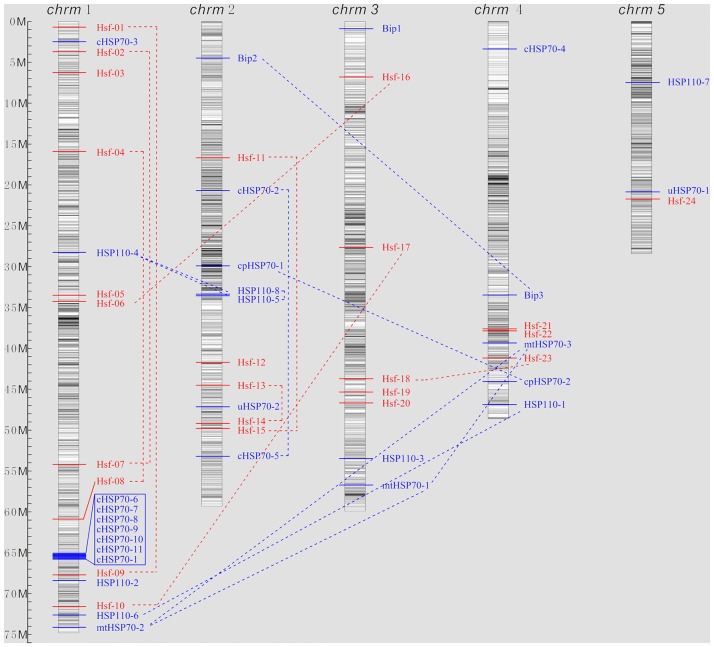
Chromosomal locations and gene duplication for B. distachyon Hsf and Hsp70 genes.The chromosomal position of each BdHsf and BdHsp70 gene was mapped according to the B. distachyon genome. The chromosome number is indicated at the top of each chromosome. The CpG island distribution maps shown in each chromosome depended on the CpG density in B. distachyon genome. The dotted line showed the gene duplication events among these BdHsf and BdHsp70 genes. The scale bar was show on the left.